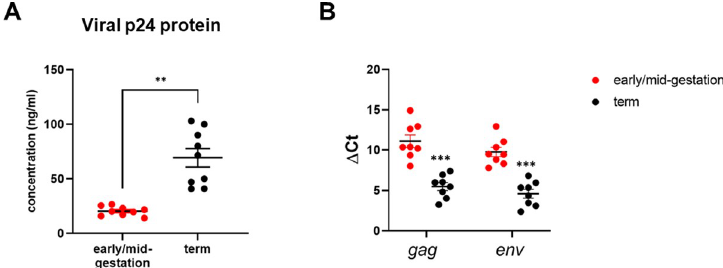
Fig 2. Term HCs are more Permissive to HIV Infection than Early/Mid-Gestation HCs. A , Human placental macrophages (HCs) were isolated from freshly obtained placenta from donors at term (black markers) or during early/ mid-gestation (red markers). HC were infected with HIV BaL strain (HIV-1 BaL ) at a multiplicity of infection of 0.1. HIV-1 replication was measured in the cell supernatants at 5 days post infection by HIV-1 p24 viral antigen enzyme- linked immunosorbent assay. Data shown represent individual donors (n = 9) analyzed by unpaired t-test analysis using the two-stage linear step-up procedure of Benjamini, Krieger and Yekutieli. �� p < 0.001 indicates significance between early/mid-gestation HCs compared to term HCs. B , Six days after viral infection, HIV-infected HC’s messenger RNA levels were measured by qRT-PCR to determine the relative expression of gag and env. Gene expression data are represented as Δ Ct (normalized to β -actin). Data shown represent individual donors (n = 9) analyzed by unpaired t-test analysis using the two-stage linear step-up procedure of Benjamini, Krieger and Yekutieli. ��� p < 0.0001 indicate significance between early/mid-gestation HCs compared and term HCs. https://doi.org/10.1371/journal.ppat.1009860.g002 abundance of activated HCs, whereas term cells appear less galvanized [5]. To investigate whether HIV infection differentially activates placental macrophages throughout gestation, we measured cell surface expression of the CD80, CDC86, HLA-DR, and CD163, at 48hpi with HIV (Fig 3). Following infection, we observed significant activation of HCs across all gesta- BaL tional ages. HIV-infected HCs isolated at term upregulated surface protein expression of CD86, HLA-DR, and CD163, while early/mid-gestation HIV-infected HCs showed significant increases in the surface expression of CD86. Although early/mid-gestation HCs exhibit a more